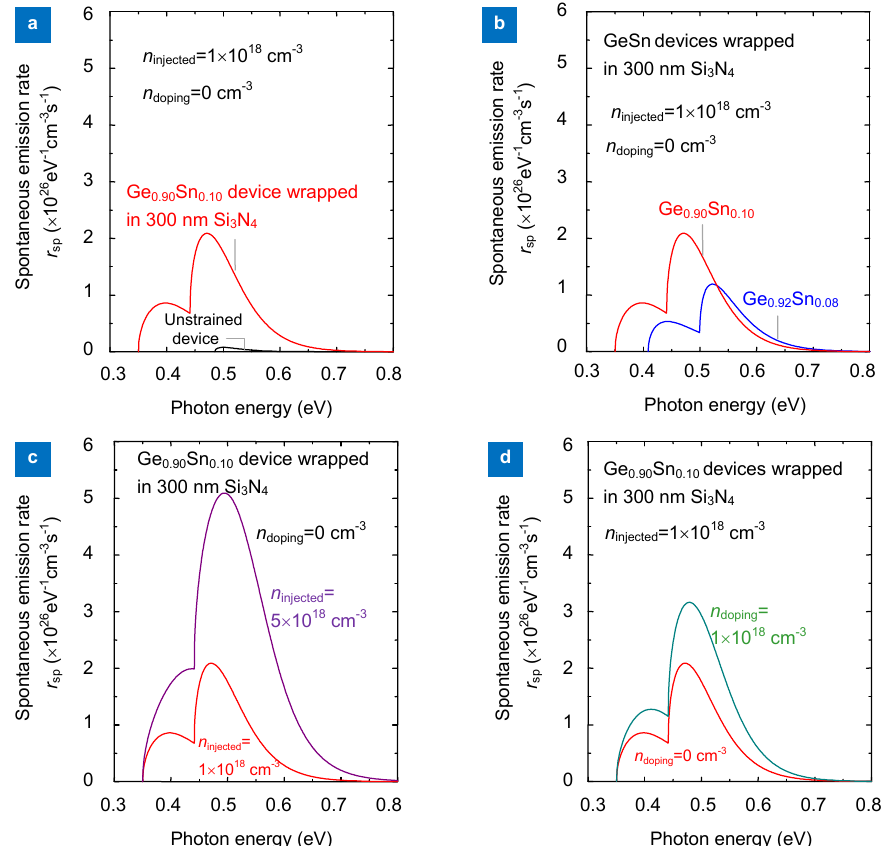
Fig. 12 | Calculated spontaneous emission spectra for the direct transition of GeSn in the lattice-matched GeSn/SiGeSn DHLEDs ( a ) under different strain status , ( b ) with different Sn compositions , ( c ) with different n injected , and ( d ) with various n doping . For all the curves, the stronger and weaker peaks represent r sp,HH and r sp,LH , respectively . Figure reproduced from ref. 37 , Optical Society of